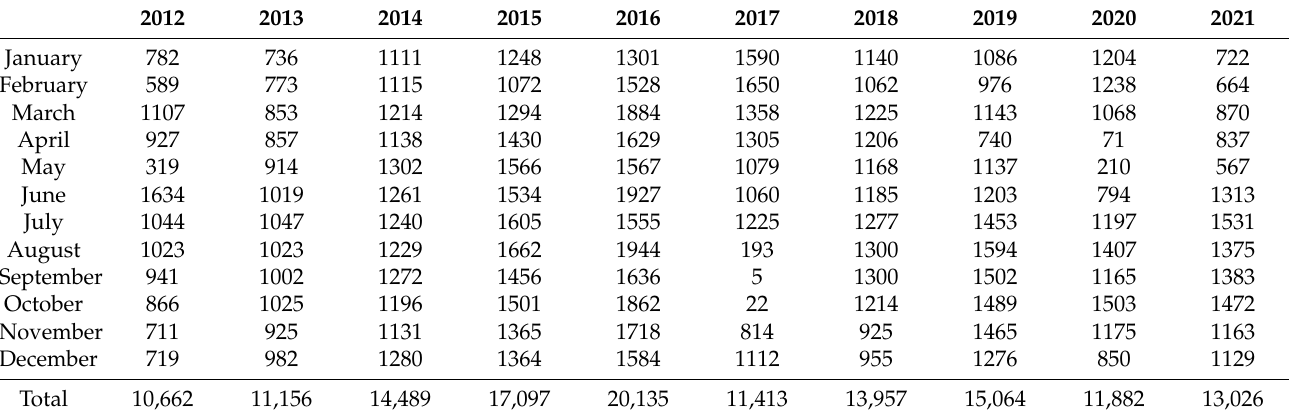
Table 5. Total traffic (IFR+VFR)